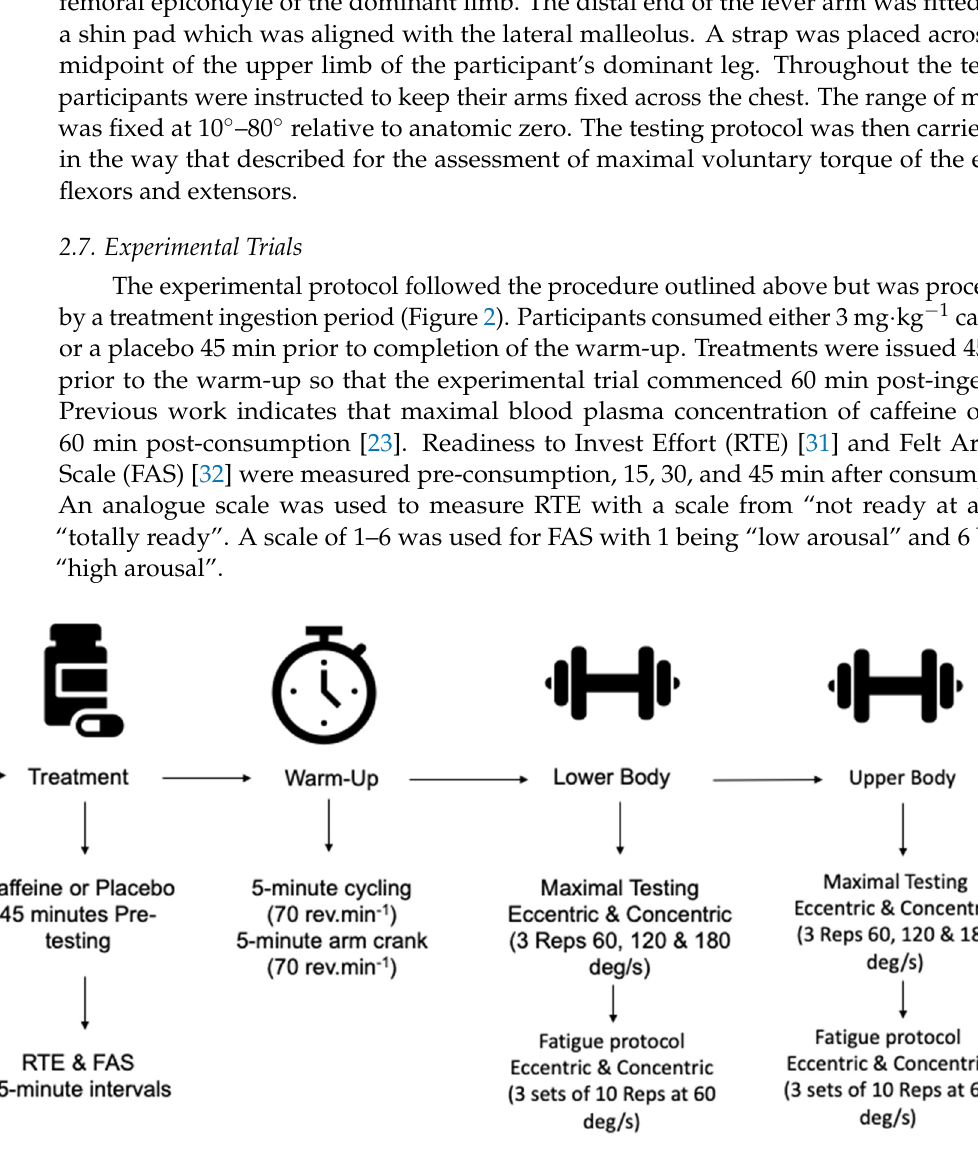
Figure 2. Schematic of the experimental Figure 2 . Schematic of the experimental trial.